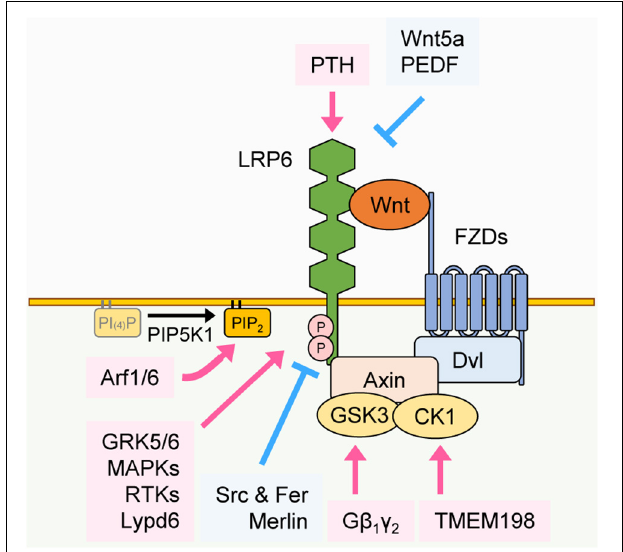
FIGURE 2 | Regulation of LRP6 phosphorylation. Phosphorylation of LRP6 can be regulated by various proteins through distinct mechanisms. PTH interacts with the extracellular domain of LRP6 and facilitates its phosphorylation. In contrast, Wnt5a and PEDF interact with the extracellular domain of LRP6 and inhibit LRP6 phosphorylation. GRK5/6, MAPKs, and RTKs facilitate phosphorylation of LRP6 in the cytoplasm, and Lypd6 facilitates phosphorylation of LRP6 in the plasma membrane. Src and Fer and Merlin inhibit phosphorylation of LRP6 in the cytoplasm. G β 1 γ 2 and TMEM198 promote phosphorylation of LRP6 in GSK3 and CK1-dependent manners, respectively. Arf1/6 facilitates the phosphorylation of LRP6 in a PIP 2 -dependent